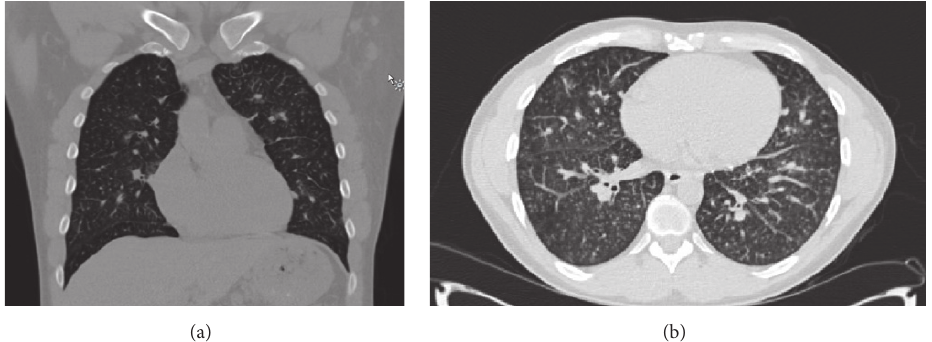
Figure 1: Coronal (a) and transverse (b) computed tomography views of the chest on first presentation. Images show ground-glass centrilobular micronodularities with perihilar ground-glass opacities. There is mild septal thickening and clear airways. Pulmonary artery is 3.3 cm, suggesting pulmonary hypertension.